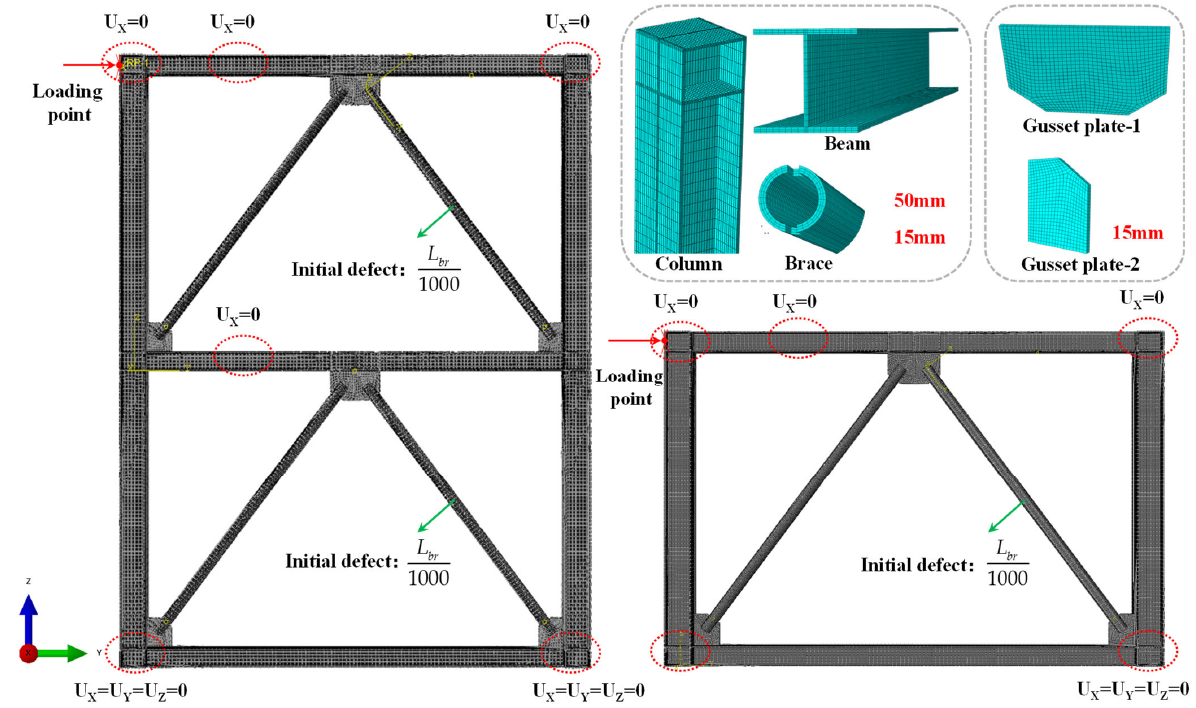
Figure 6. Details of the FE model of a concentrically–braced steel frame.